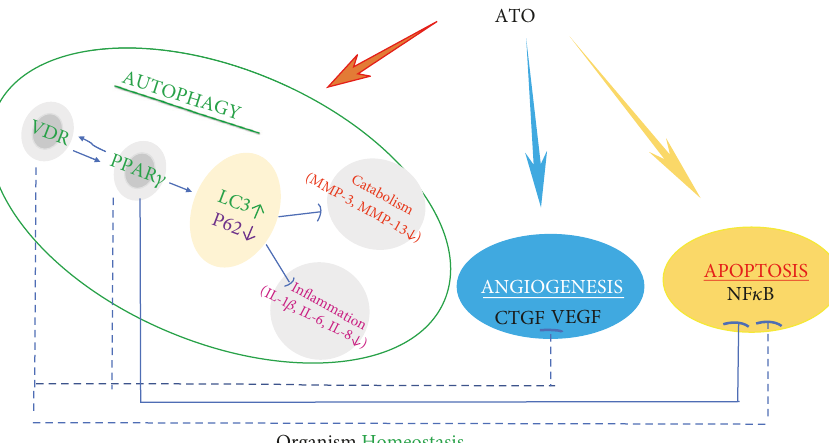
Figure 6: Regulation effect of ATO on VDR-PPAR- 𝛾 functional module . The Vitamin D receptor (VDR) and PPAR- 𝛾 interplay with each other and form a functional module. ATO rescued defective autophagy by regulating this functional module in synovial fibroblasts, thus inhibiting the expression of inflammatory and catabolic factors. Serving as a regulatory mechanism, autophagy has complex interrelationships with other physiological processes including angiogenesis and apoptosis, which can be regulated by ATO. The solid lines indicate our original data or results from our study that have been corroborated by other labs; dotted lines indicate that research is still